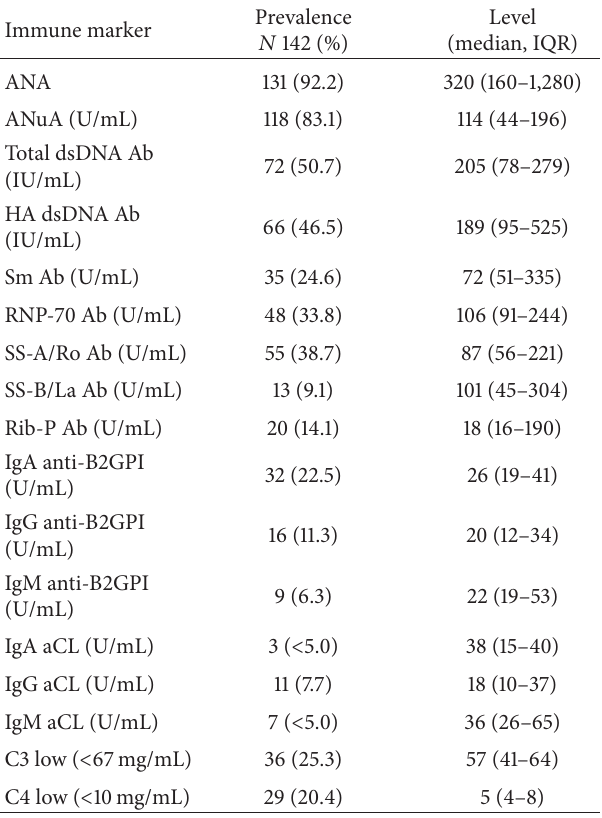
Table 1: Immunological findings in Brazilian SLE